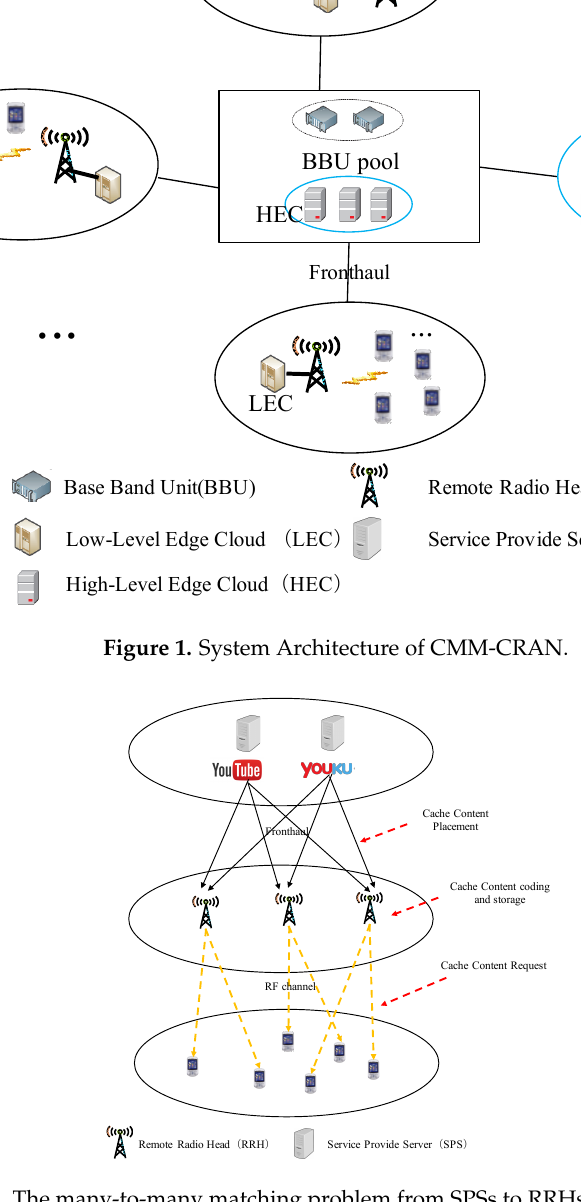
Figure 2. The many-to-many matching problem from SPSs to RRHs in